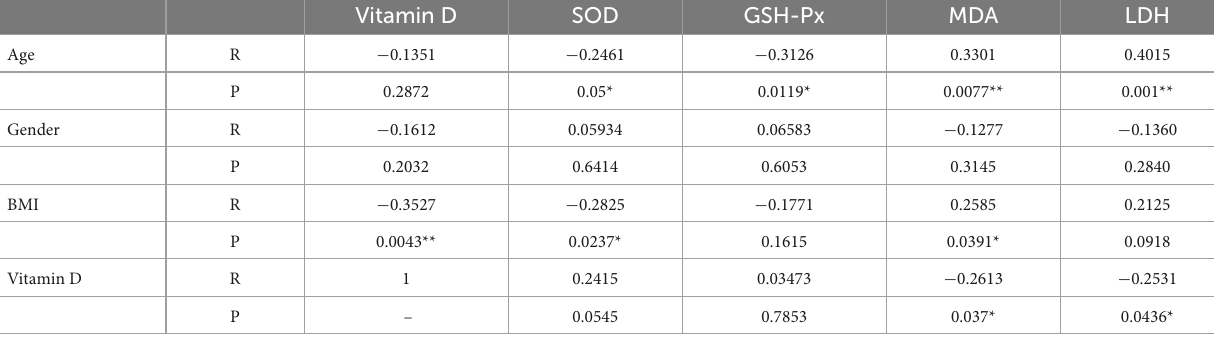
TABLE 4 Correlation analysis of the differences between demographic data, vitamin D levels, and OS. Vitamin